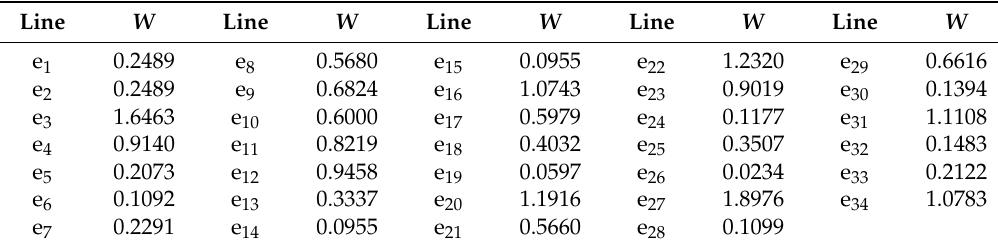
Table 4. Calculation result of transmission